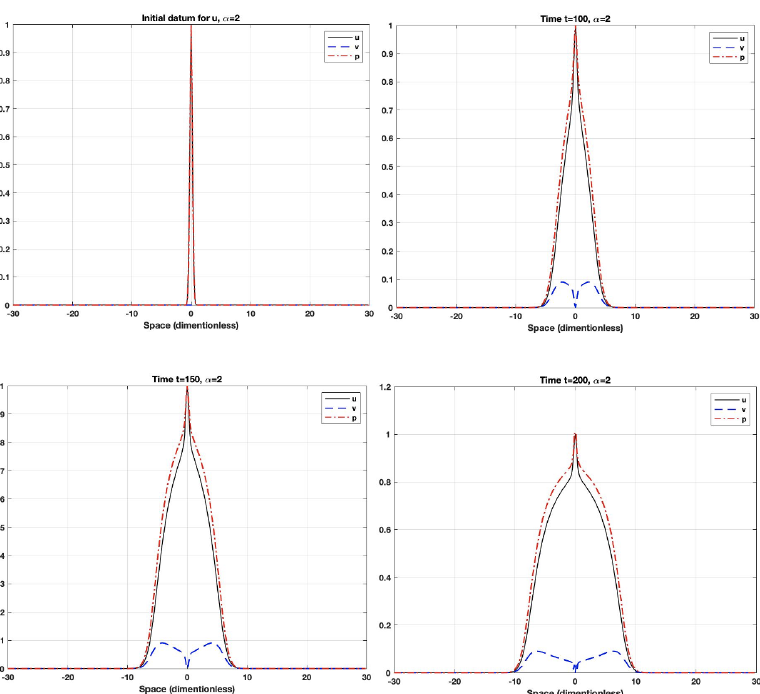
Figure 2. Distribution of CSCs (black), NSCCs (blue) and total tumour density (red). For high mortality rate of NSCCs ( α = 2 ) at various total times T ∈ { 0,100,150,200 } and fractional order of time derivative β = 0.6.